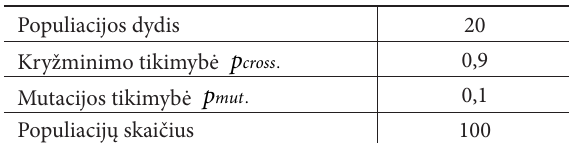
Table 2. Genetic algorithm parameters